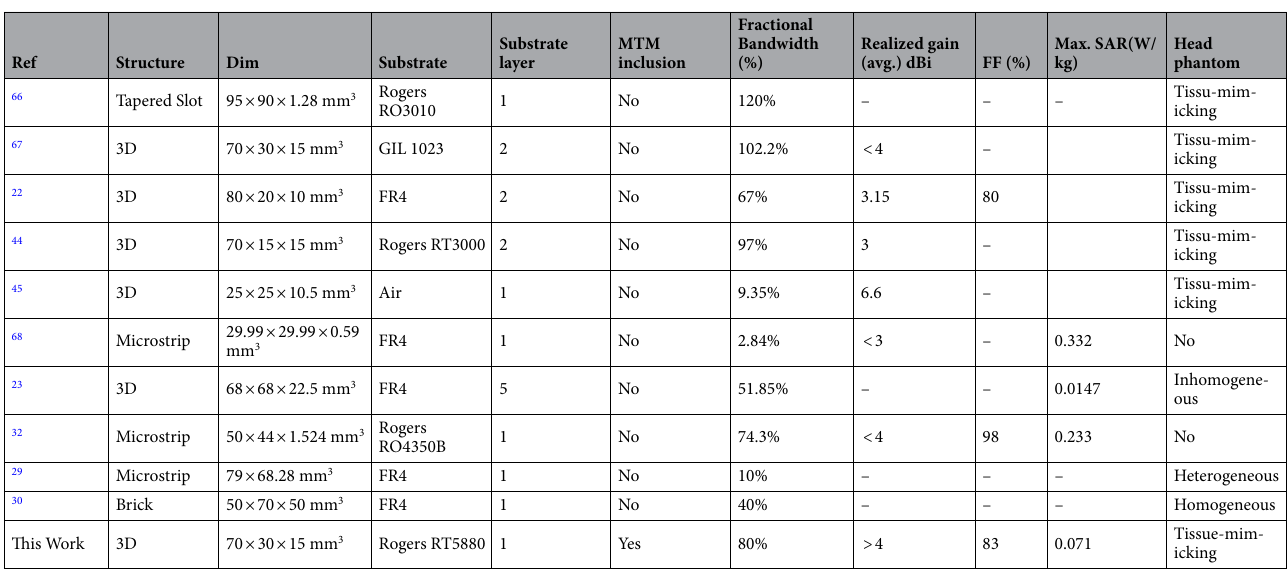
Table 3. Comparison among proposed and other existing works in microwave head imaging